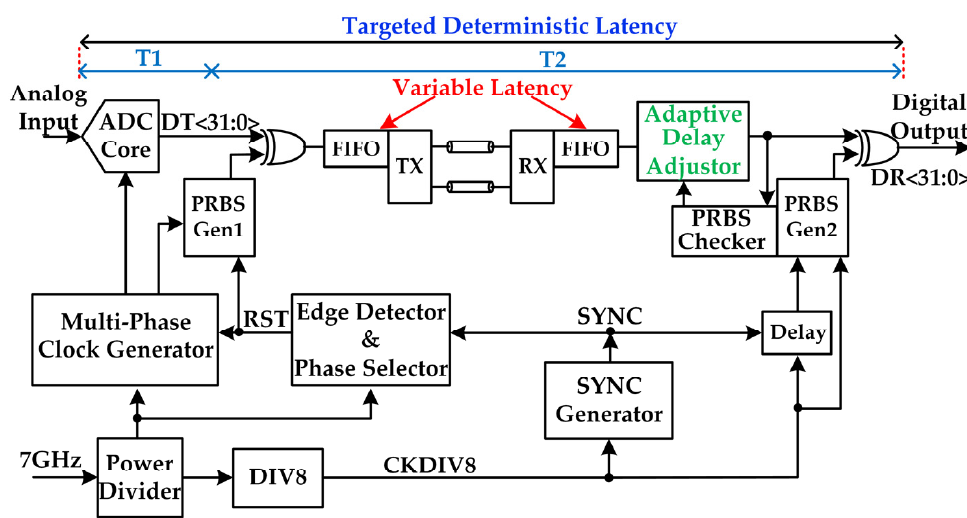
Figure 9. Deterministic latency and synchronization diagram.